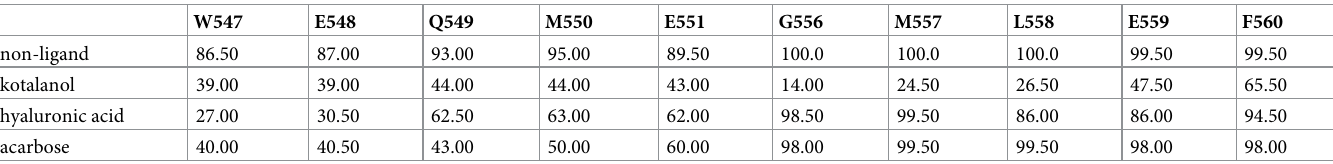
Table 2. The probability (%) for alpha (residue 530–580) of the four systems during MD simulations. W547 E548 Q549 M550 E551